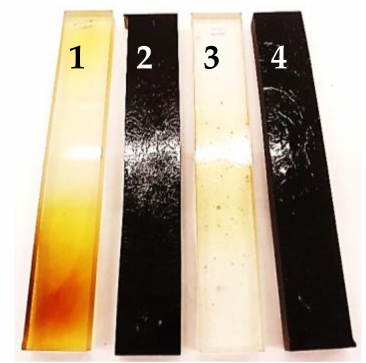
Figure 4. Images of the UPR and VER lignin-based composites after 80 min of microwave irradiation.